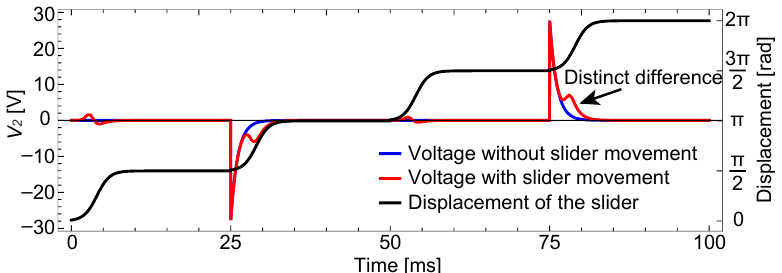
Figure 5. Analytical results for four consecutive motion steps. The slider moves one electrode pitch, which is π /2 in the normalized displacement, at every voltage shift. The red line shows the result when a slider is moving over the sensing electrode, and the blue line shows that without a slider. From the difference between the two output waveforms, the existence of the slider can be